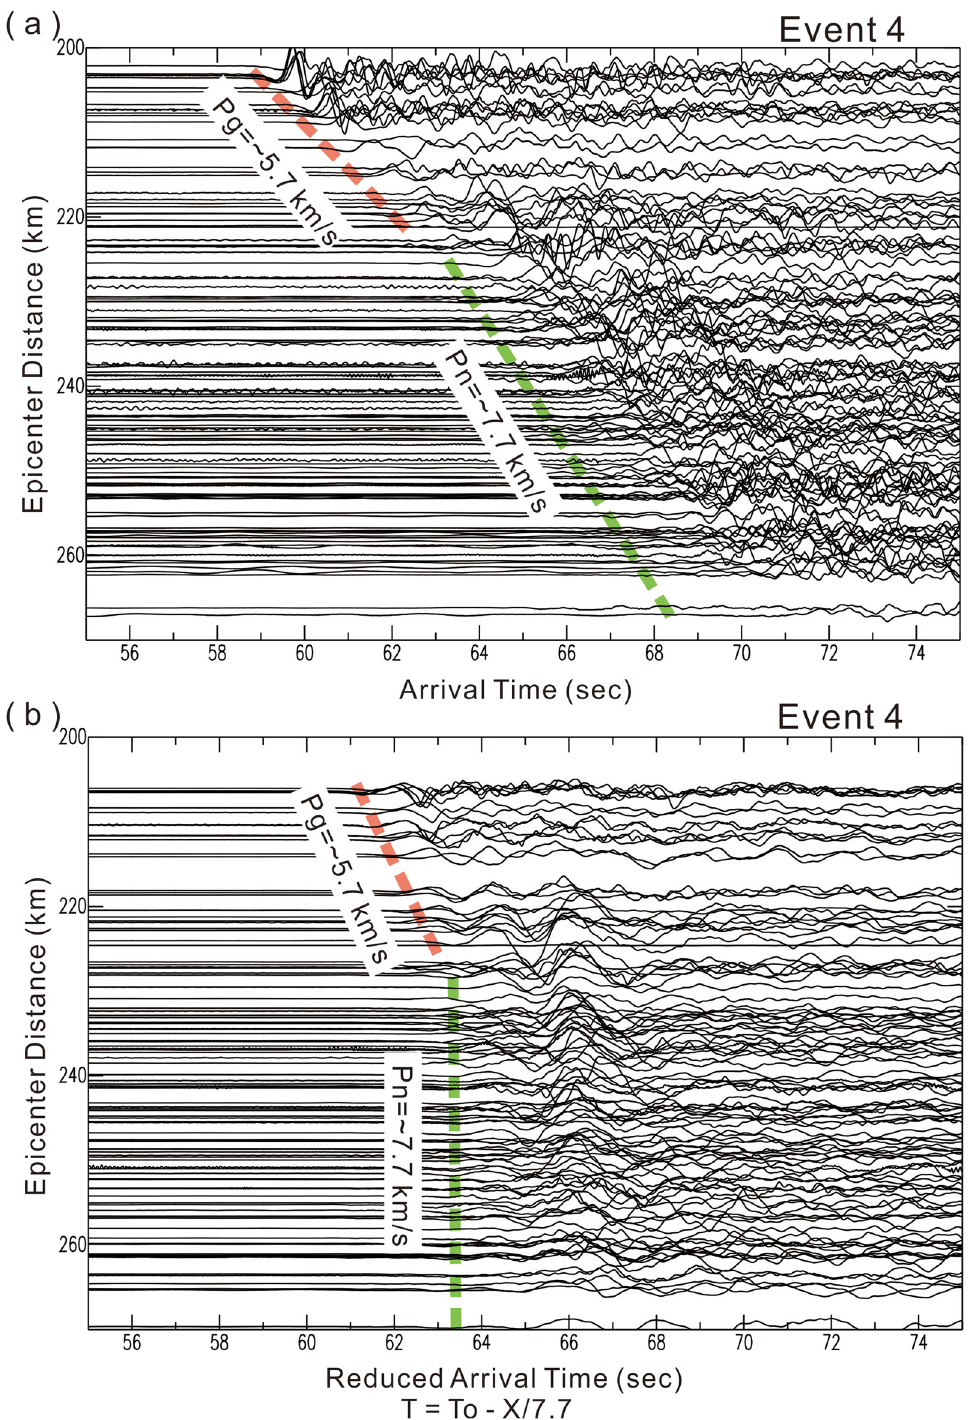
Fig. 7 Vertical seismograms generated by Event 4 and recorded by the Formosa Array. Seismograms a directly plotted with epicenter distances, and b with arrival times corrected by a reduced velocity of 7.7